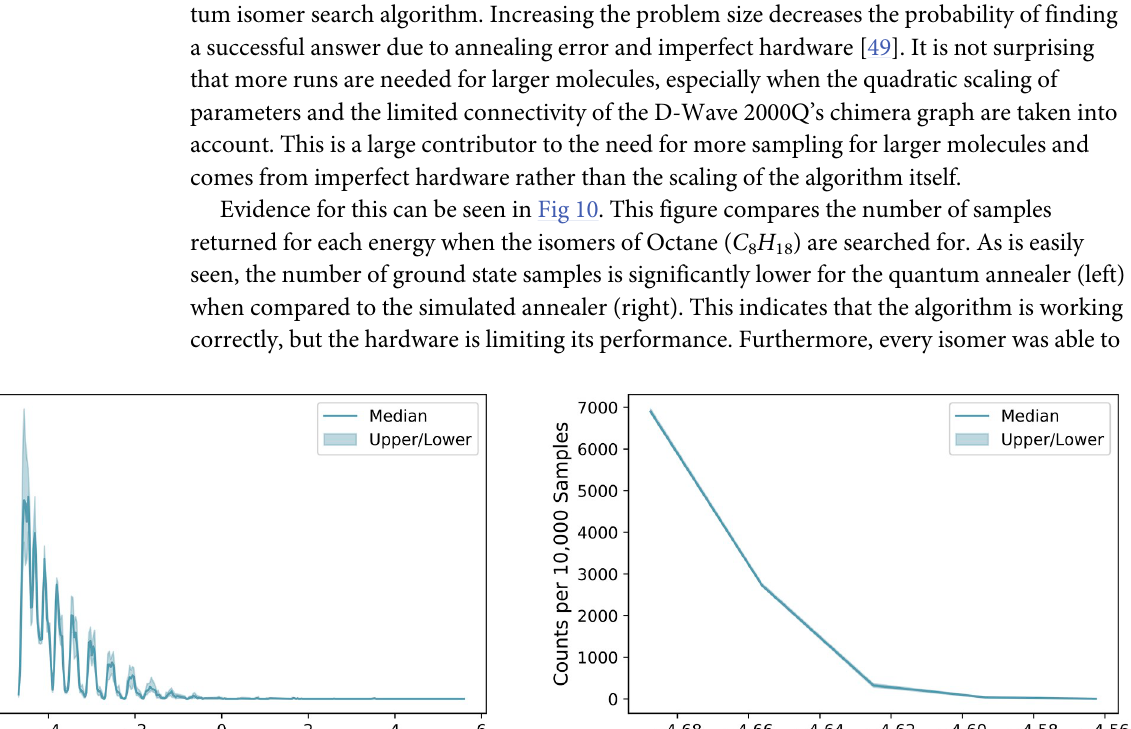
PLOS ONE | https://doi.org/10.1371/journal.pone.0226787 January 15,